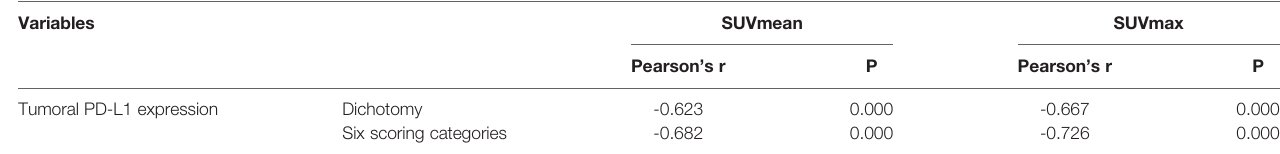
TABLE 1 | Correlations between 18 F-RGD PET/CT imaging parameters and tumoral PD-L1 expression in mice.